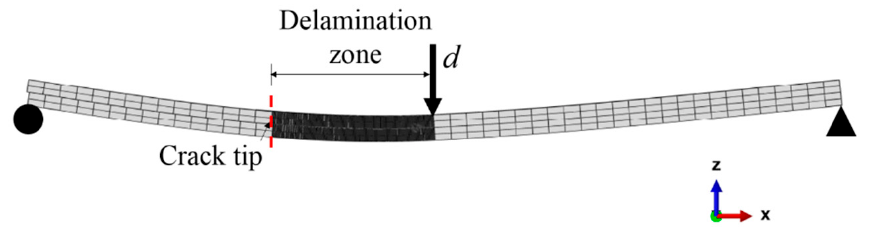
Figure 8. Finite element model of the ENF specimen.